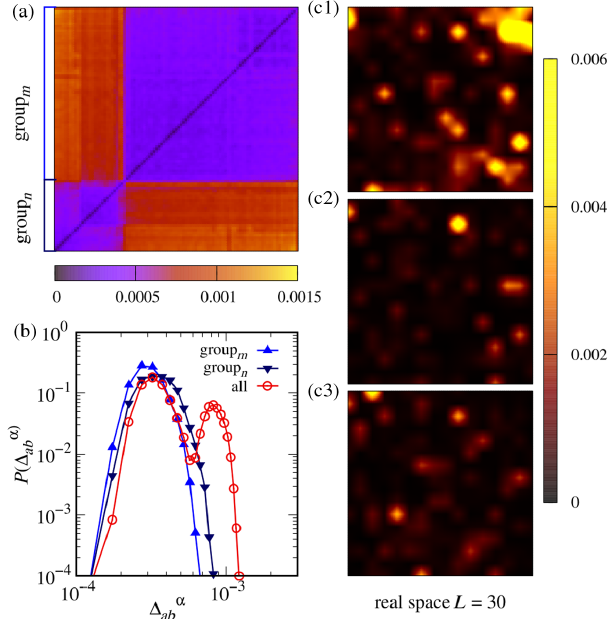
FIG. 6. Emerging complexity in the landscape of individual sample α with N ¼ 1024 for Z ¼ 600 > Z . (a) Heat map of G ¼ 2 18 × 100 , with the clone index cage-relative MSD at t w ranging from 1 to 100 after clustering. The clones can be divided into two subpopulations, group and group . (b) Corresponding m n Þ for all clones, group probability distributions P ð Δ α and m ab . (c1) – (c3) Cage-relative displacement field for clones group n belonging to different groups (c1), group (c2), and group m n